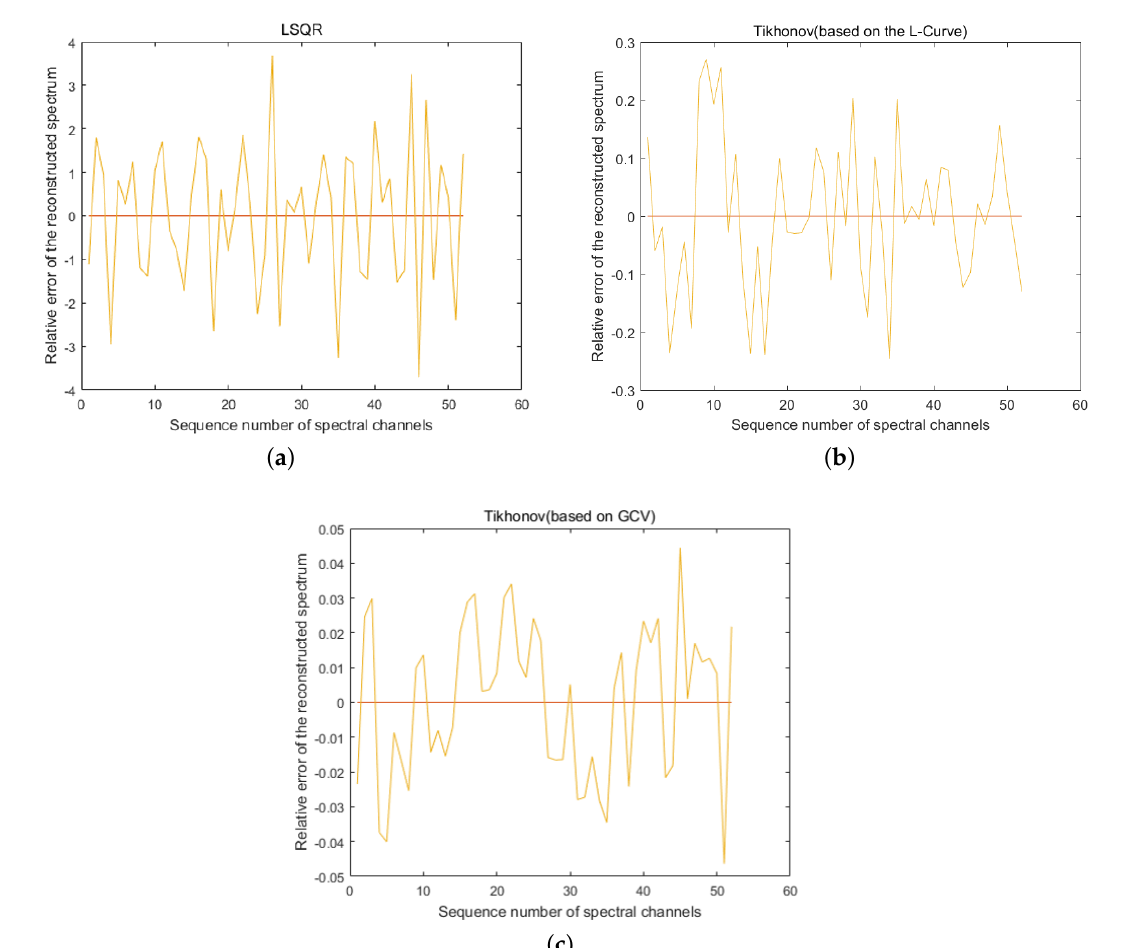
Figure 4. Reconstruction of the spectrum by the algorithm when the modulation function R calibrates the standard deviation σ to 1%. ( a ) The spectral accuracy recovered using the least squares (LSQR) method reached a maximum error of 400%. ( b ) The maximum error in spectral accuracy recovered using the Tikhonov method based on the L-curve reached 28%. ( c ) The maximum error in spectral accuracy recovered using the generalized cross-validation (GCV)-based Tikhonov method was only 5%. We measured the accuracy of the reconstructed spectra using the evaluation criteria in Section